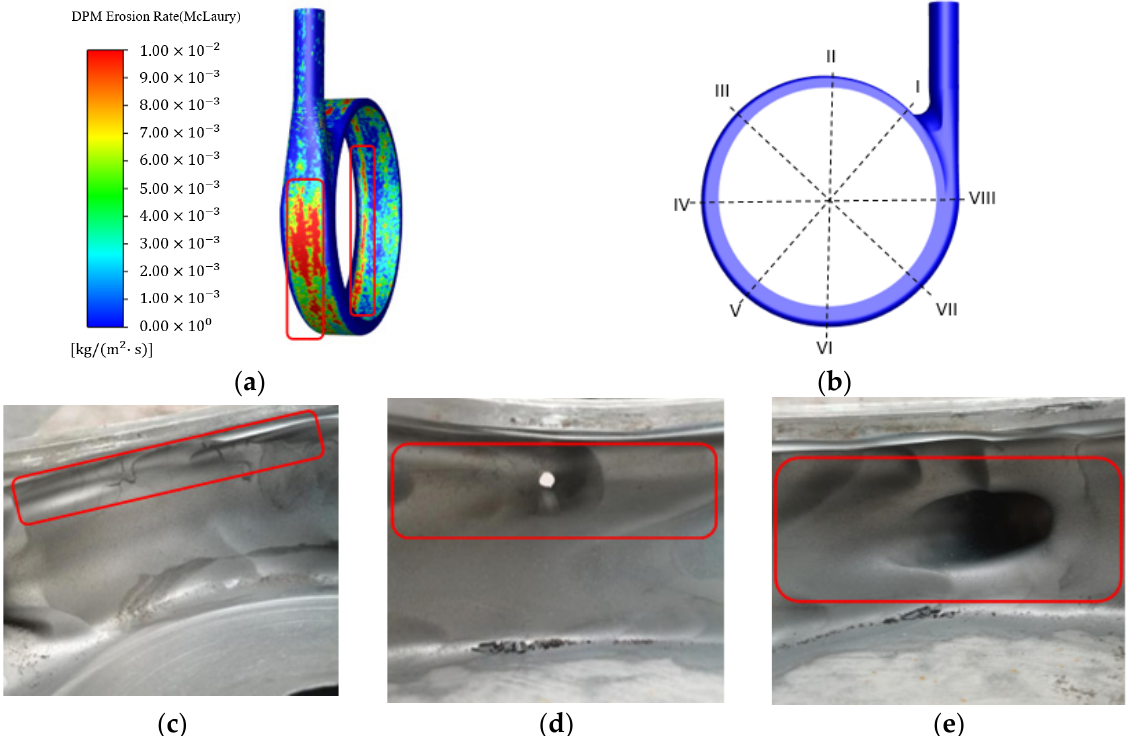
Figure 9. Wear comparison at middle section of blade pressure surface: ( a ) simulation; ( b ) volute cross - section; ( c ) experiment, sections I to II; ( d ) experiment, sections IV to V; ( e ) experiment, sections VI to VIII.